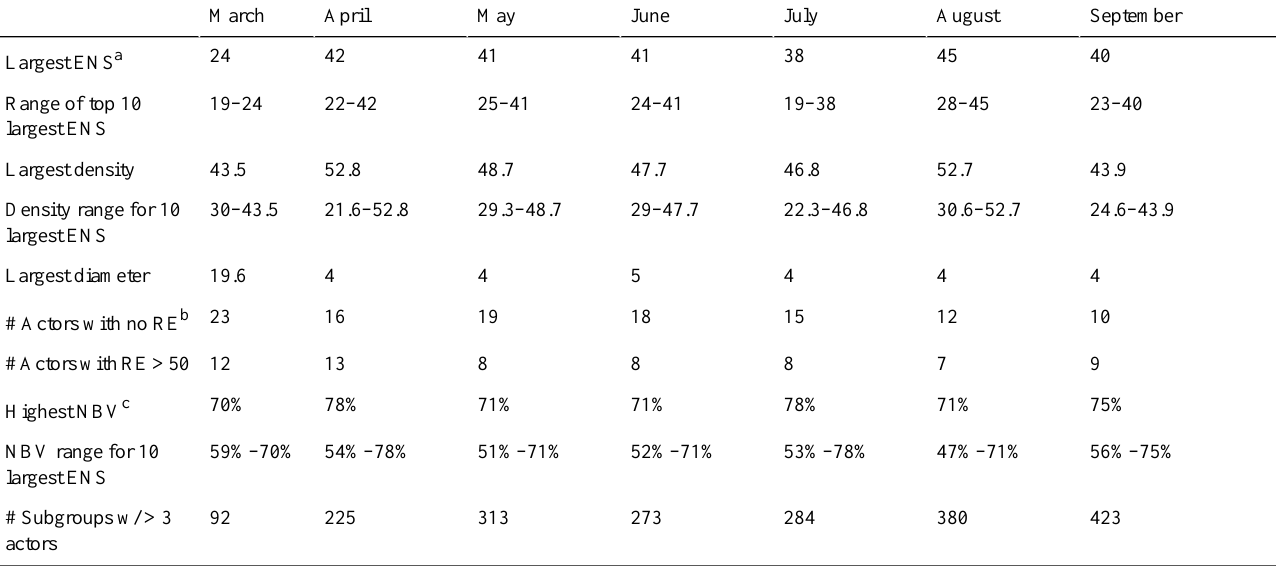
Table 1. Summary of ego-network measures of the Airtel mobile phone closed user group by month from March 2011 to September 2011 (source: Airtel closed user group call data).